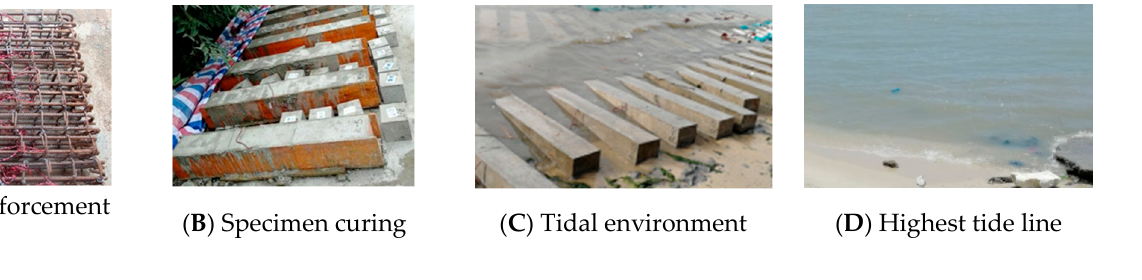
Figure 2. Specimen fabrication and tidal environment.